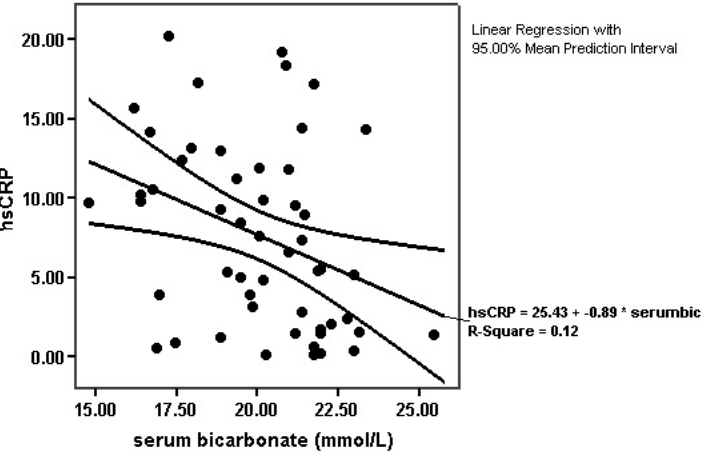
Figure 1. Association between serum bicarbonate levels and hsCRP ( r = − 0.384, p = 0.005).